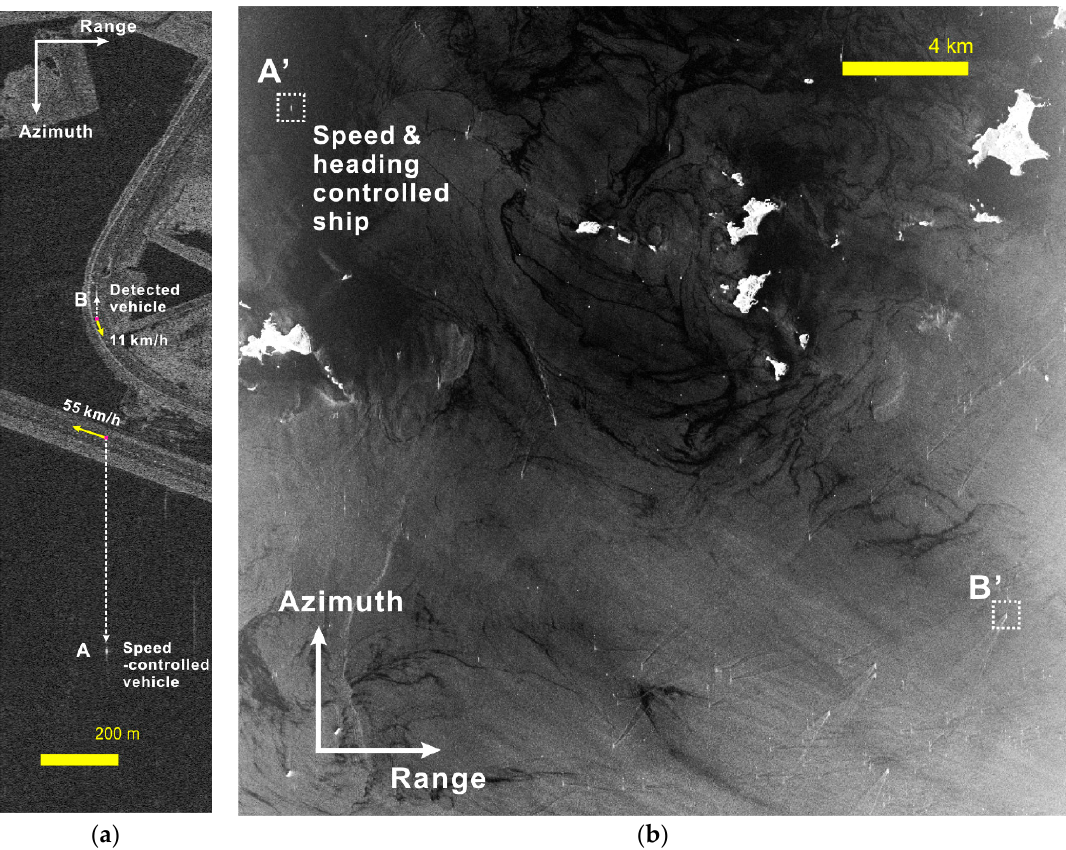
Figure 1. Two synthetic aperture radar (SAR) images used in this study: ( a ) TerraSAR-X SLC image, in which a speed-controlled vehicle A is observed. ( b ) KOMPSAT-5 SLC image over coastal areas, in which a speed and heading controlled ship A’ for the experiment, as well as numerous high velocity ships, are observed.